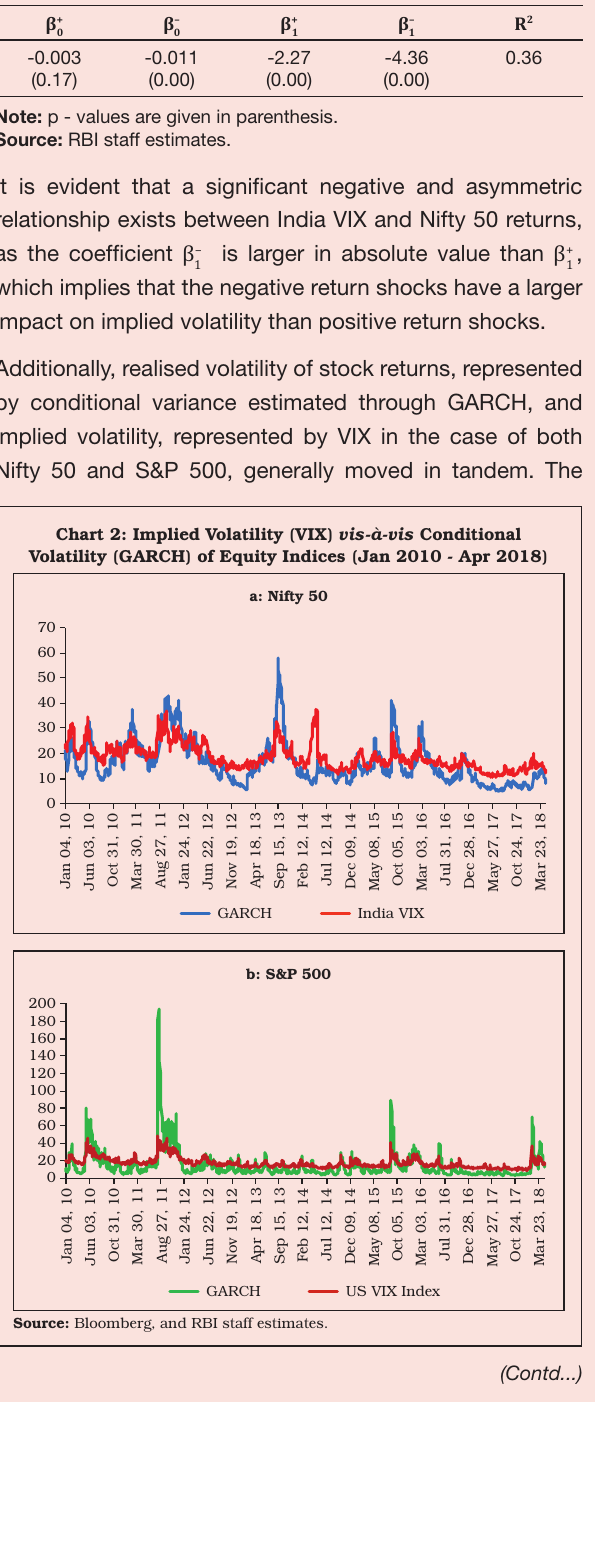
Table 2: estimated coefficients of the Regression